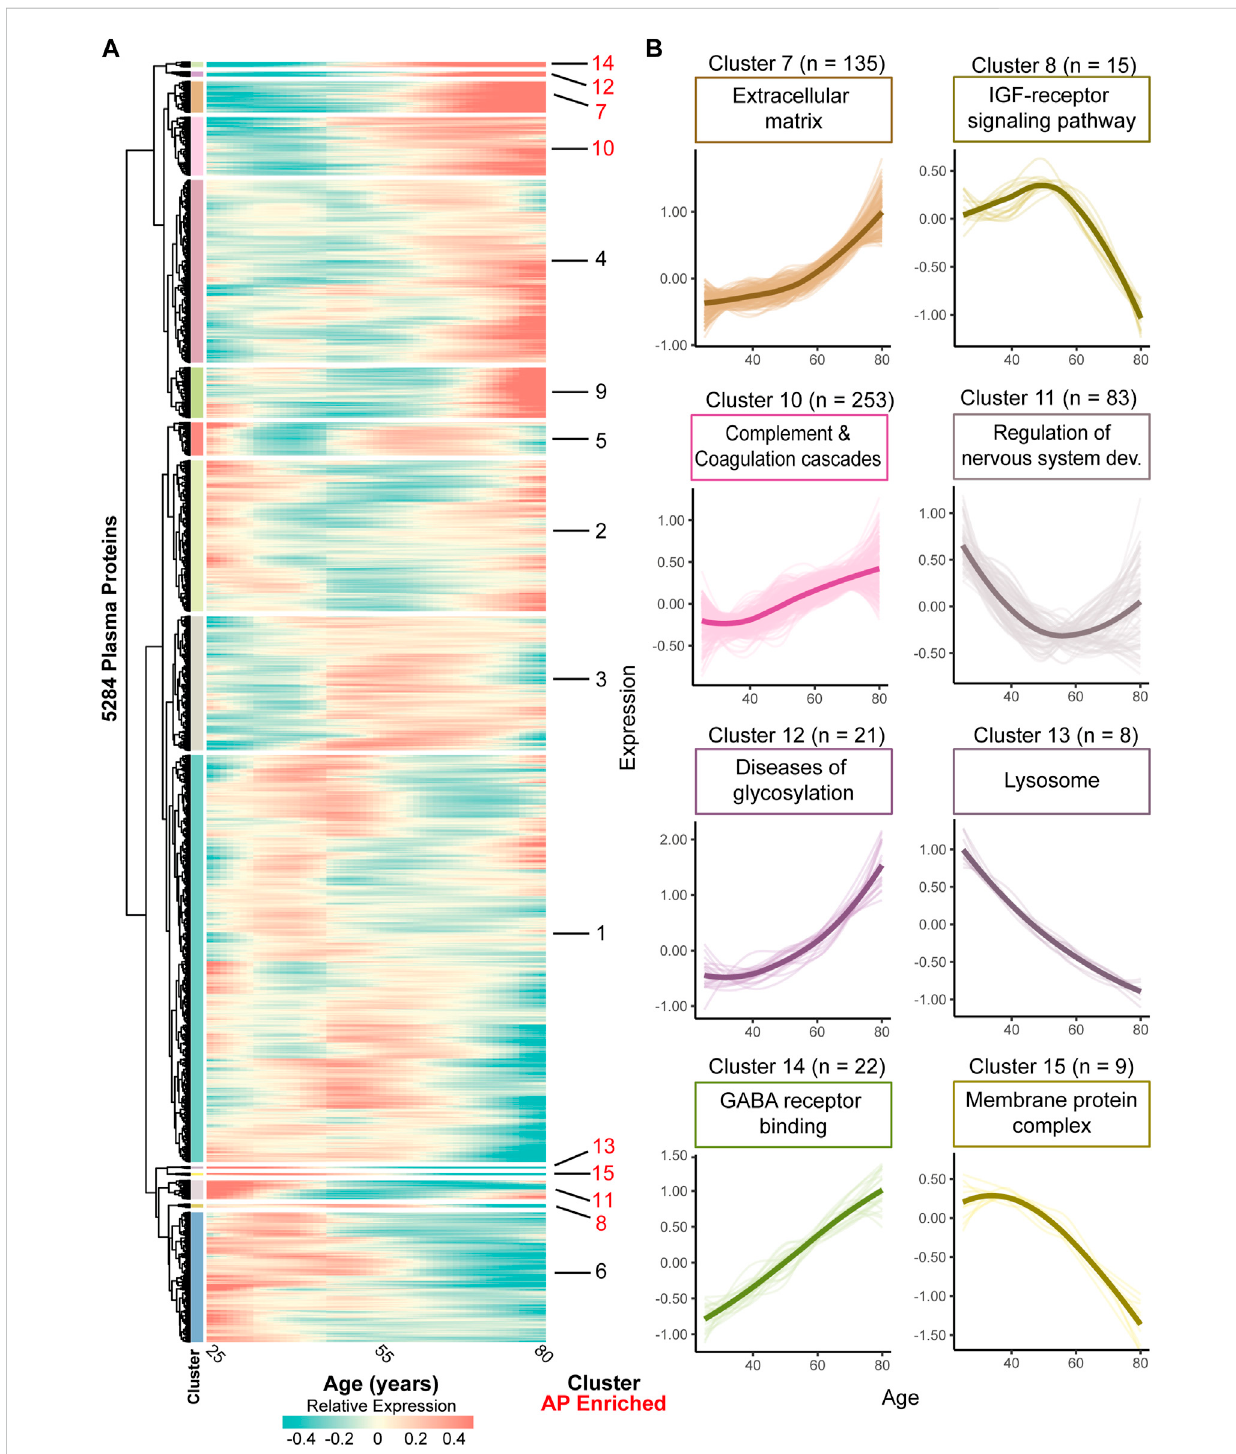
FIGURE 2 Clustering the complete plasma proteome on expression trajectories reveals AP enriched clusters involved in various functions. (A) Heatmap of identi fi edclustersfollowingunsupervisedanalysesofallplasmaproteinsbasedonexpressiontrajectoriesacrossageusingproteomicdataofArthur,etal. (Arthur et al., 2021) Color bars next to the dendrogram denote the individual clusters. Cluster numbers are marker red when enriched for APs using a hypergeometric test (q < .05). In the expression trajectory, blue colors indicate a relative decrease whereas red colors indicate a relative increase compared tothemeanexpressionovertime. (B) ZoominofAP enrichedclustersandthenumberofincludedproteinswithin eachclusterasindicatedby ‘ n ’ . Thick lines represent the average expression trajectory of the cluster, and thin lines denote the trajectory of individual proteins. Above each cluster trajectory an example term of enriched function, molecular component, or pathway was included (all FDR < .05). For a complete overview of enriched GO-, KEGG- and Reactome terms within each cluster, see Supplementary Table